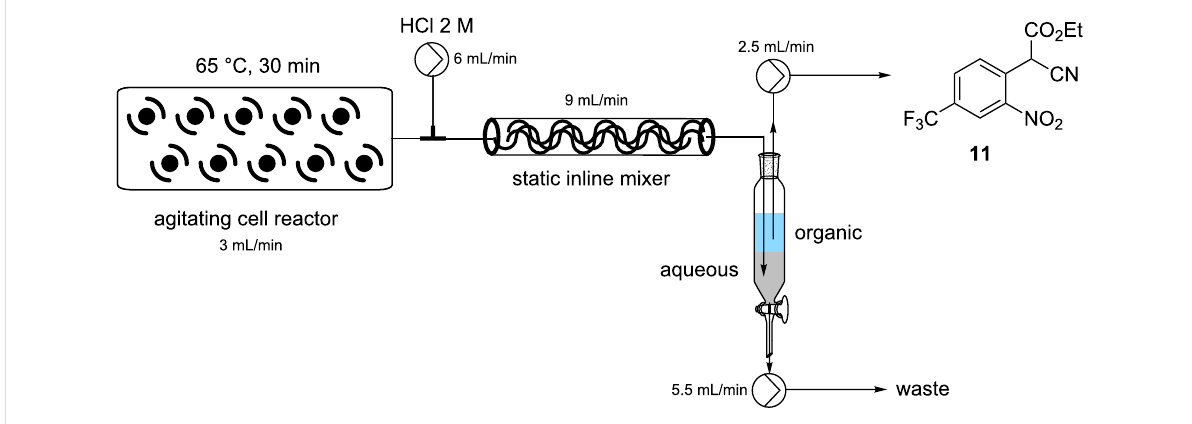
tion of substrate 9 . Under continuous operation the reactor output was a dark red suspension comprising approx. 10% solid by volume but was easily processed through the system even over extended periods of time (>14 h). This set-up gave a theo- retical working throughput of 0.108 mol/h. Next, to facilitate the integrated quenching and work-up we added a static mixing element [15] at the confluence point of an aqueous solution of 2 M HCl delivered at a flow rate of 6 mL/min (Scheme 4). Evi- dence for effective quenching was immediately observed by the transformation of the dark red reaction mixture to a pale yellow biphasic solution which quickly phase separated upon collec- tion. Confirmation of the successful quenching was obtained by 1 H NMR and LC analysis of the organic phase which indicated only the product 11 and trace amounts of ethyl cyanoacetate ( 10 ). Finally, manual separation followed by drying over Na 2 SO 4 and solvent evaporation gave the desired product 11 in 94–96% yield, based upon 6 sampled aliquots of 20 min each processing